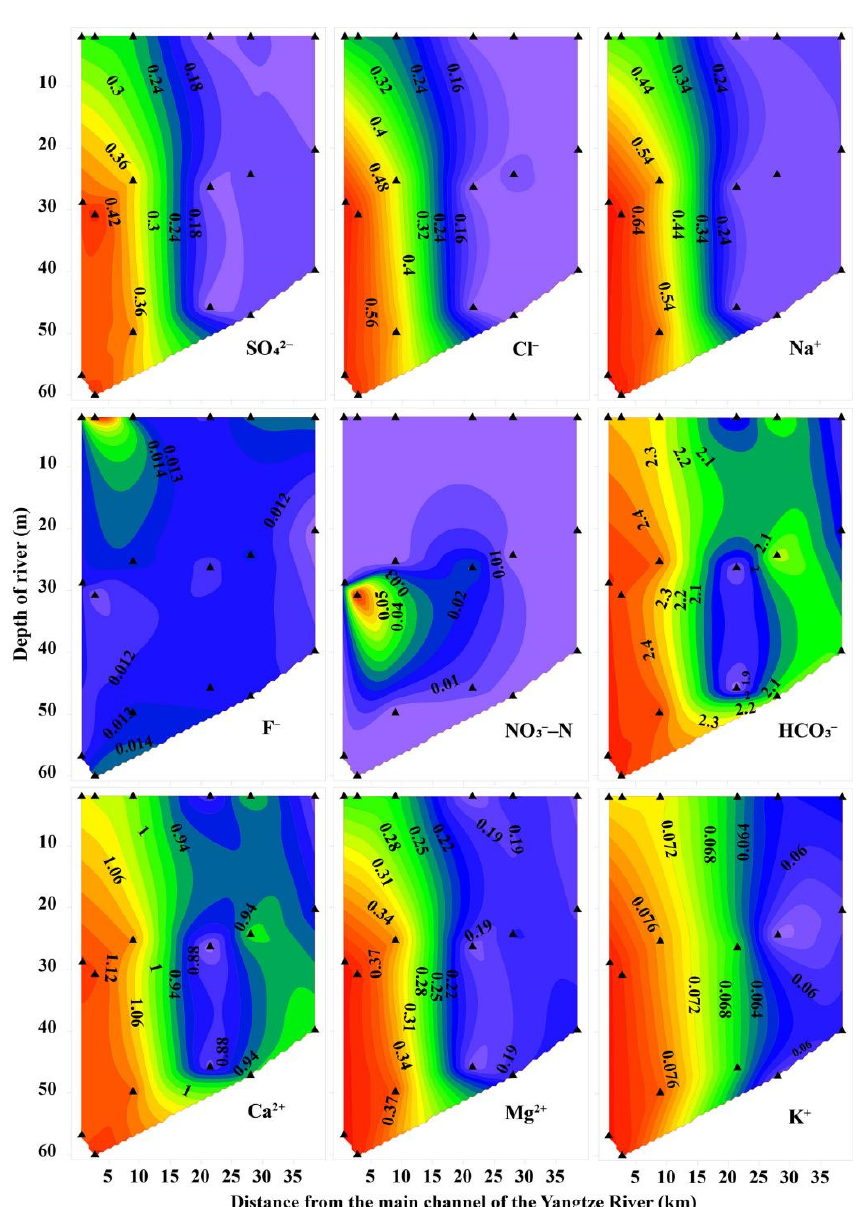
Figure 3. The vertical distribution of ionic concentrations of stratified water samples in Xiaojiang River. Black triangles represent sampling points at different depths. Higher ionic concentration is represented by red color, and the lower ionic concentration with blue color.